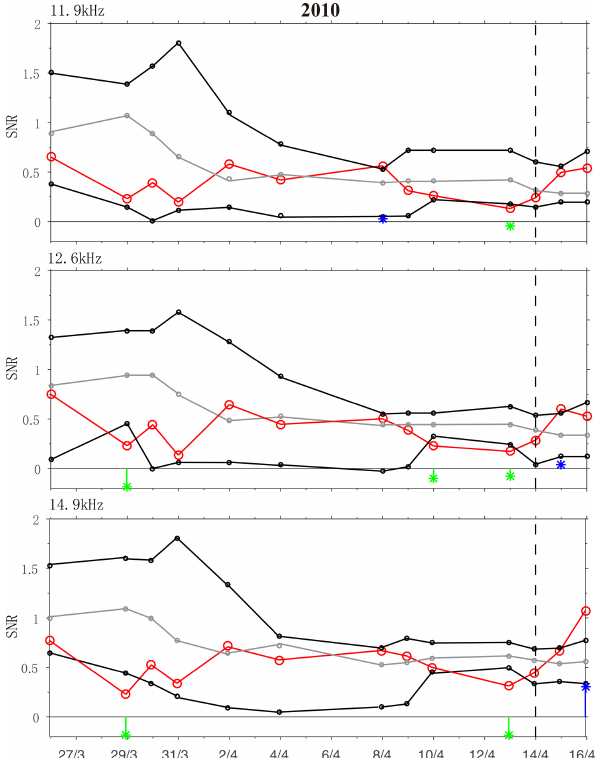
Figure 4. A time series of SNR right above the Yushu epicenter. The Ms 7.1 Yushu earthquake occurred at the local time of 07:49:37.9 on 14 April 2010. The red, gray, and two black curves denote the currently observed SNR, associated median, and upper and lower bound (UB and LB), respectively. Blue and green sign represent the upper and lower anomalous days identified by the computer routine, respectively. The LB and UB are constructed by the previous 1– 11d moving median (M), lower quartile (LQ), and upper quartile (UQ), and the LB and UB are calculated by LB = M + 2(M-LQ) and UB = M +